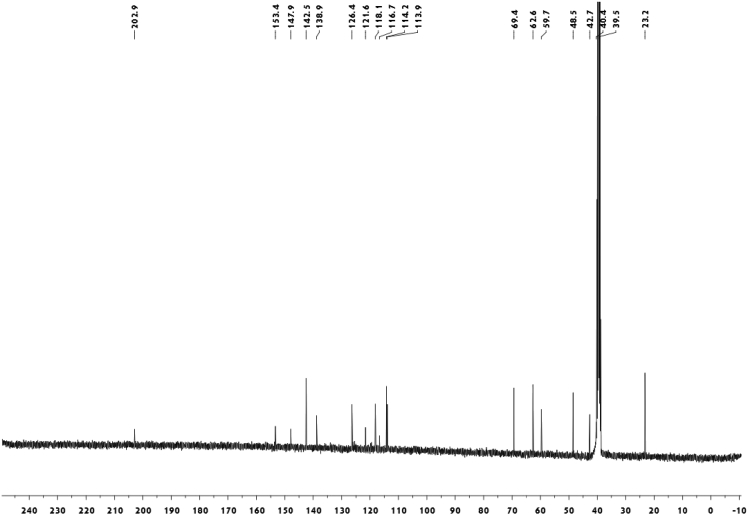
13C-NMR spectrum of meroterpenoid 7.